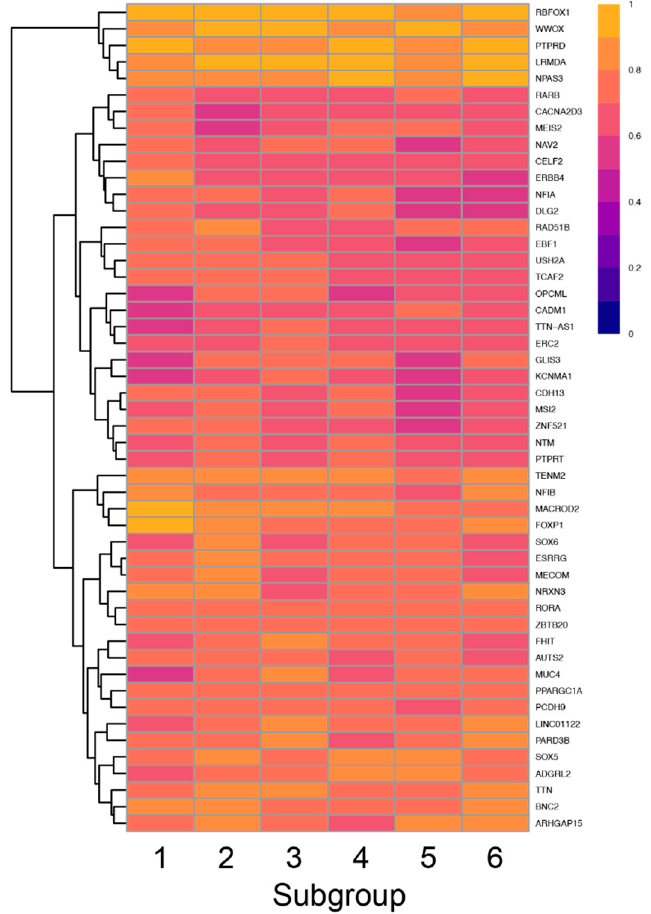
Figure 8. Heatmap showing the frequency of variants in each subgroup (columns) for the top 50 genes (rows) with the highest GVF demonstrating the variation in GVF across subgroups.